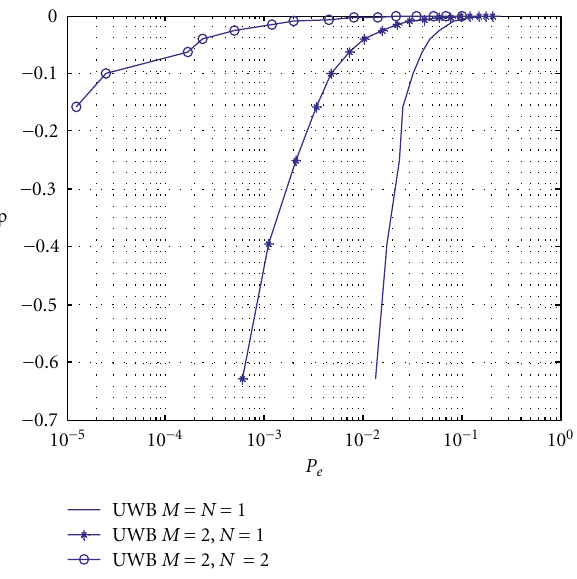
Figure 3: Anti-jamming performance comparison of UWB and CDMA.